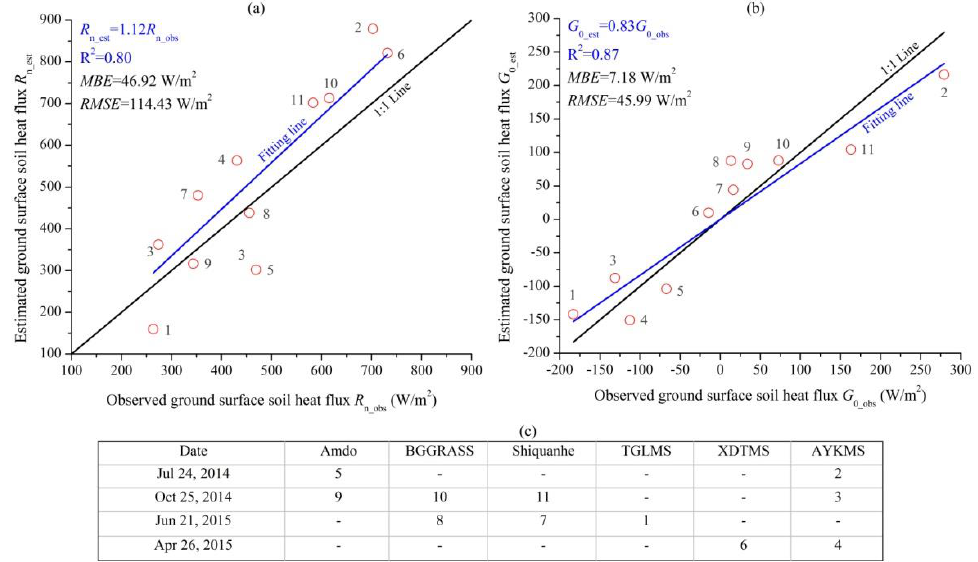
Figure 8. Validation of estimated net radiation ( a ) and ground surface soil heat flux ( b ) with in-situ measurements (The gray numbers (1–11) in Figure 8a,b represent the sites and dates corresponding to the red circles, shown in the table ( c )). Note: RMSE , root mean square error; MBE , mean bias error; R 2 , the coefficient of determination.